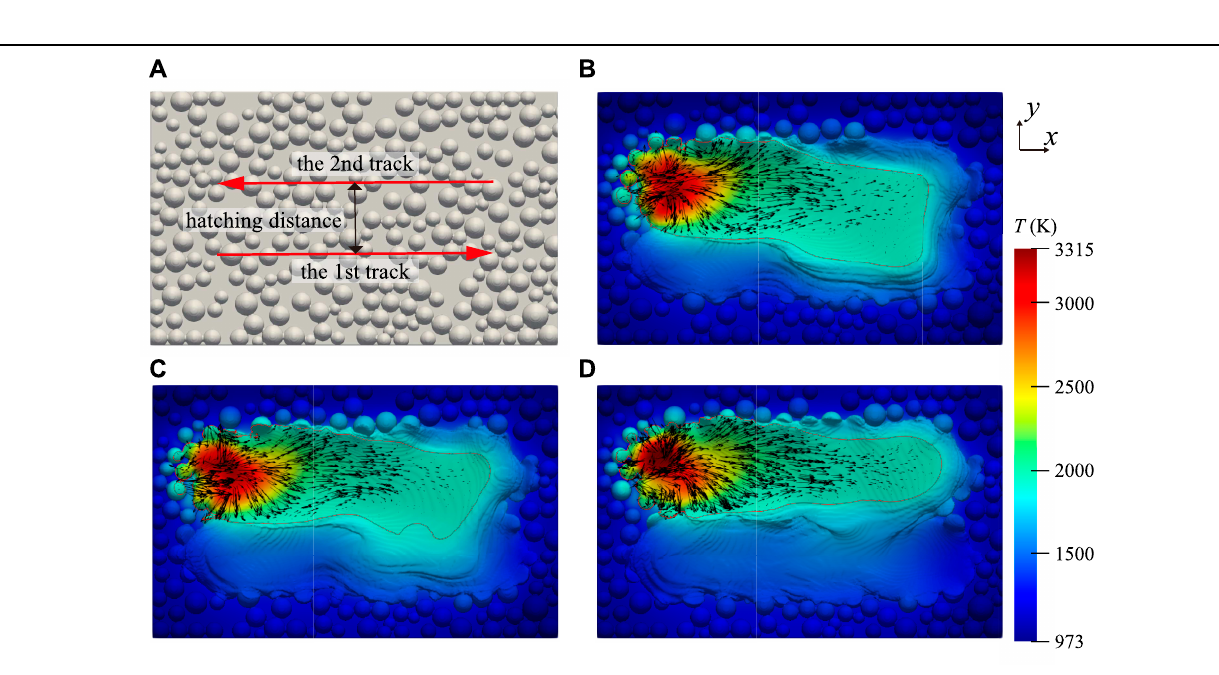
Frontiers in Materials |